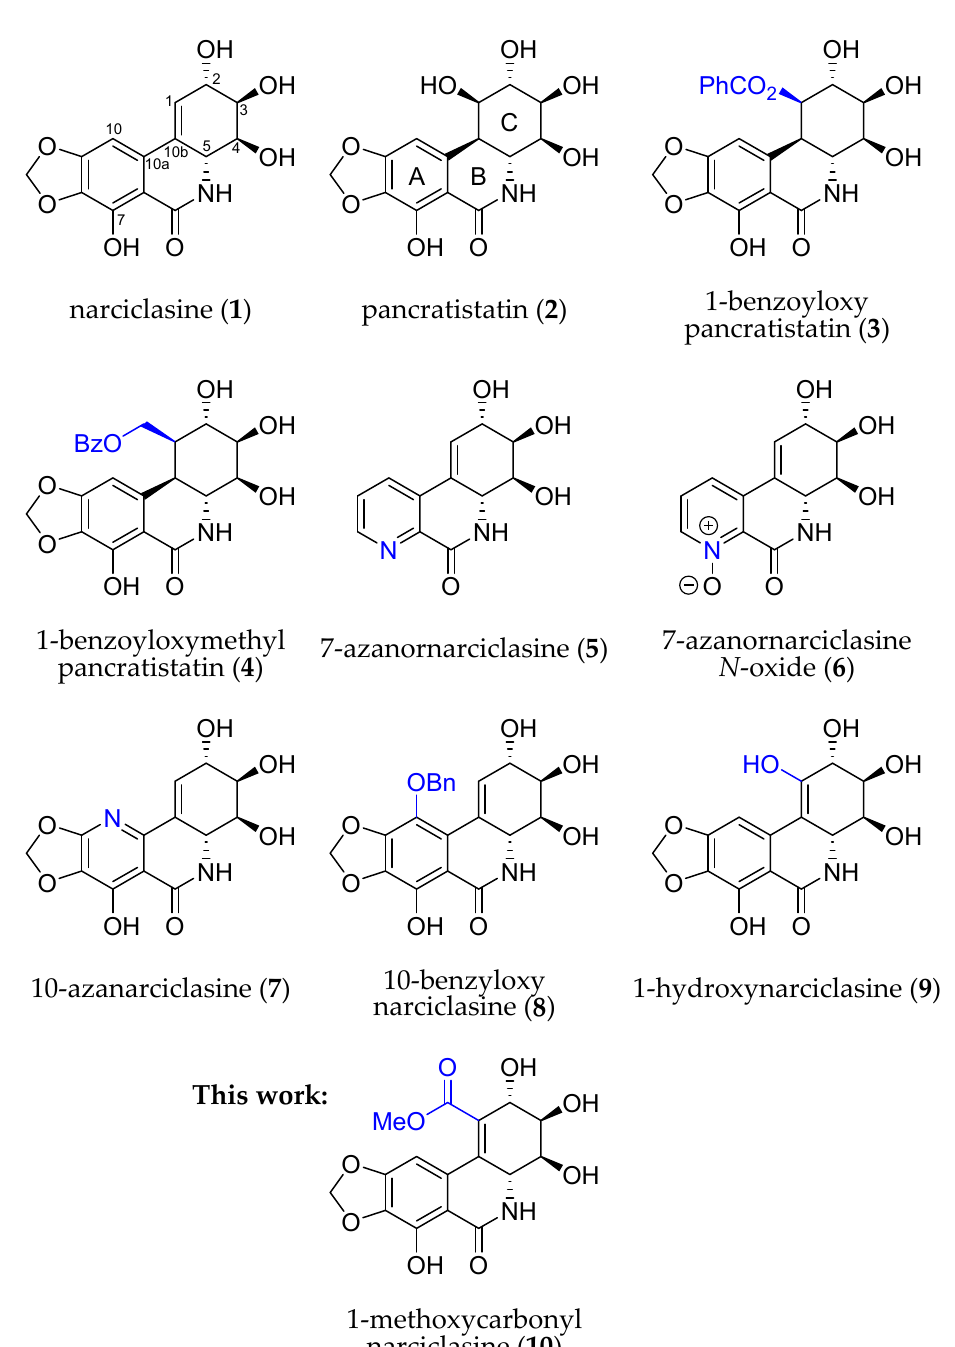
Figure 1 Figure 1. Naturally occurring Amaryllidaceae constituents (compounds 1 and 2 ), C-1 derivatives of pancratistatin with enhanced biological activity (compounds 3 and 4 ) and representative derivatives of narciclasine (compounds 5 – 10